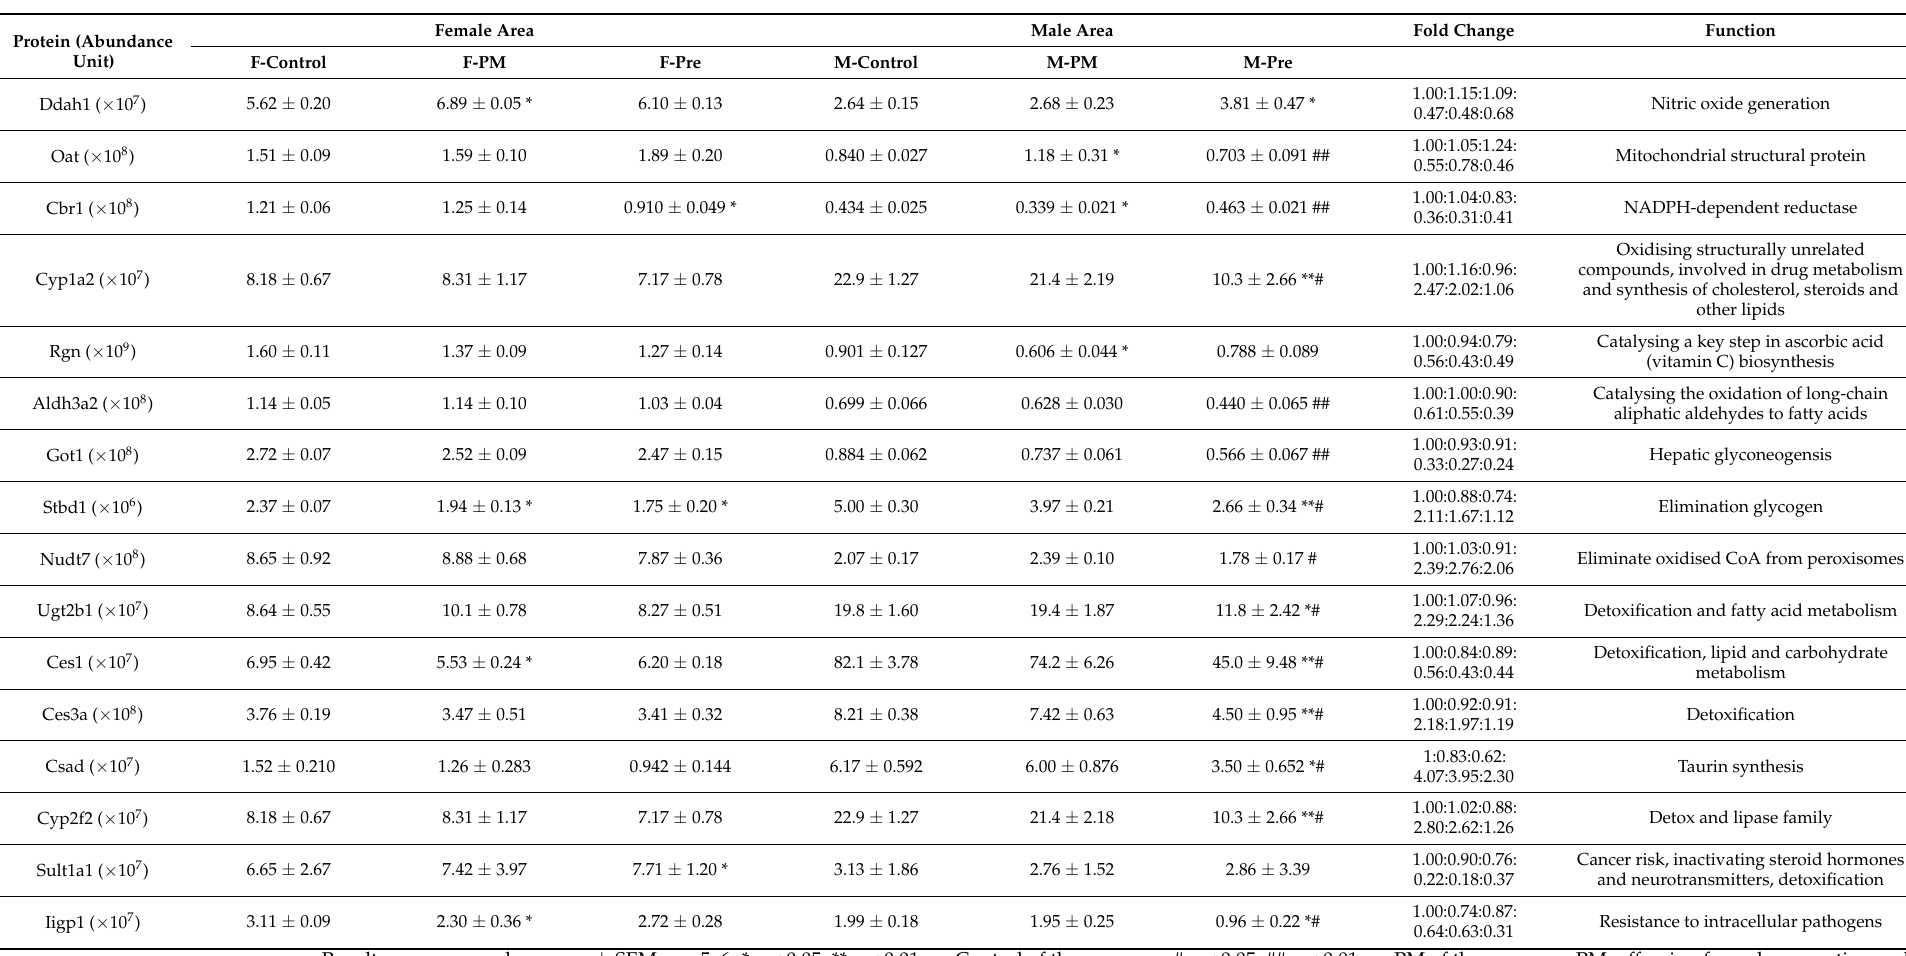
Table 3. Peptide abundance area for top-3 peptides used for quantification by Peaks Studio XPro. Fold changes are compared to the